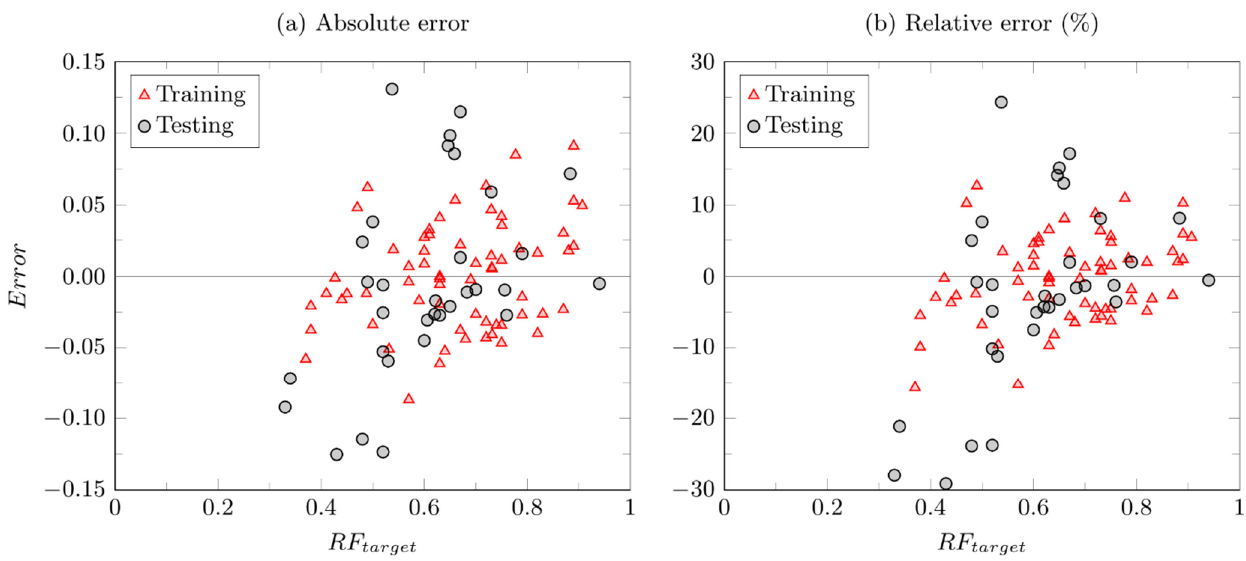
Figure 7. Scatter absolute error ( a ) and relative error ( b ) plots of training and testing phases.